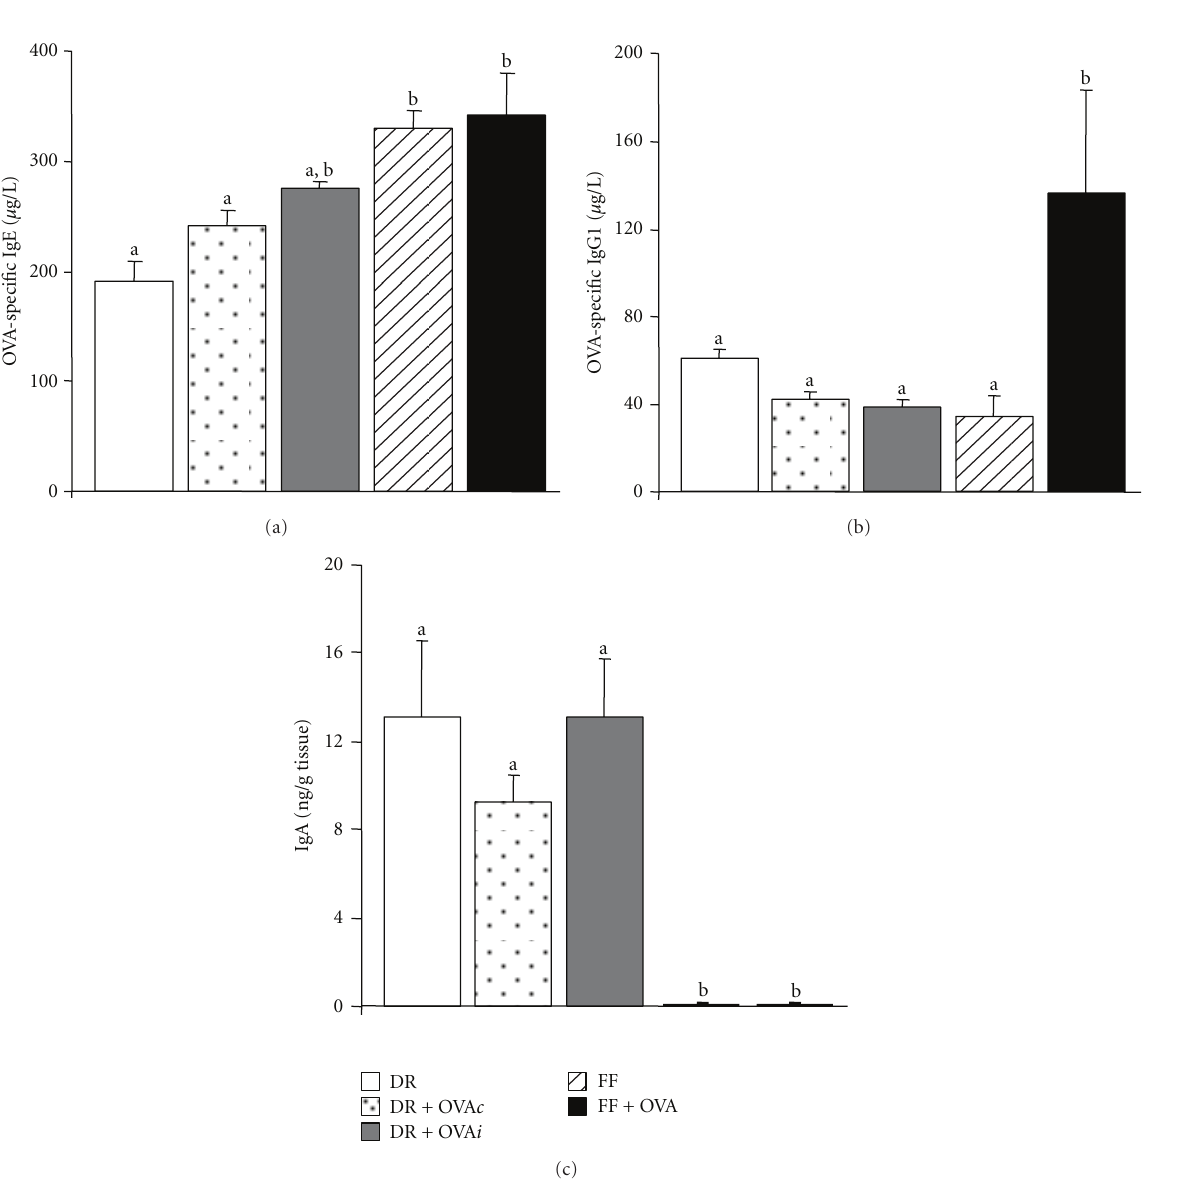
activation and allergy development resulted when BLG was fed in the presence of formula